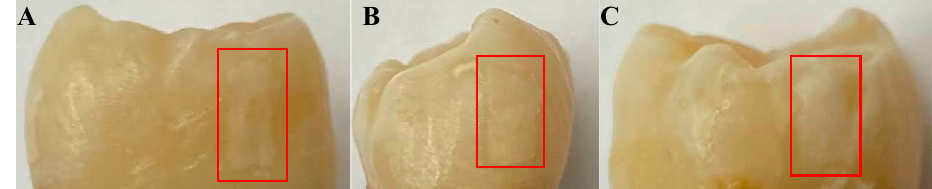
Figure 2. Optical images of the ( A ) buccal, ( B ) distal, and ( C ) lingual surfaces of sample B8 after 8 days of cariogenic biofilm exposure. The lesions formed by the cariogenic biofilm exposure are outlined by the red rectangles.